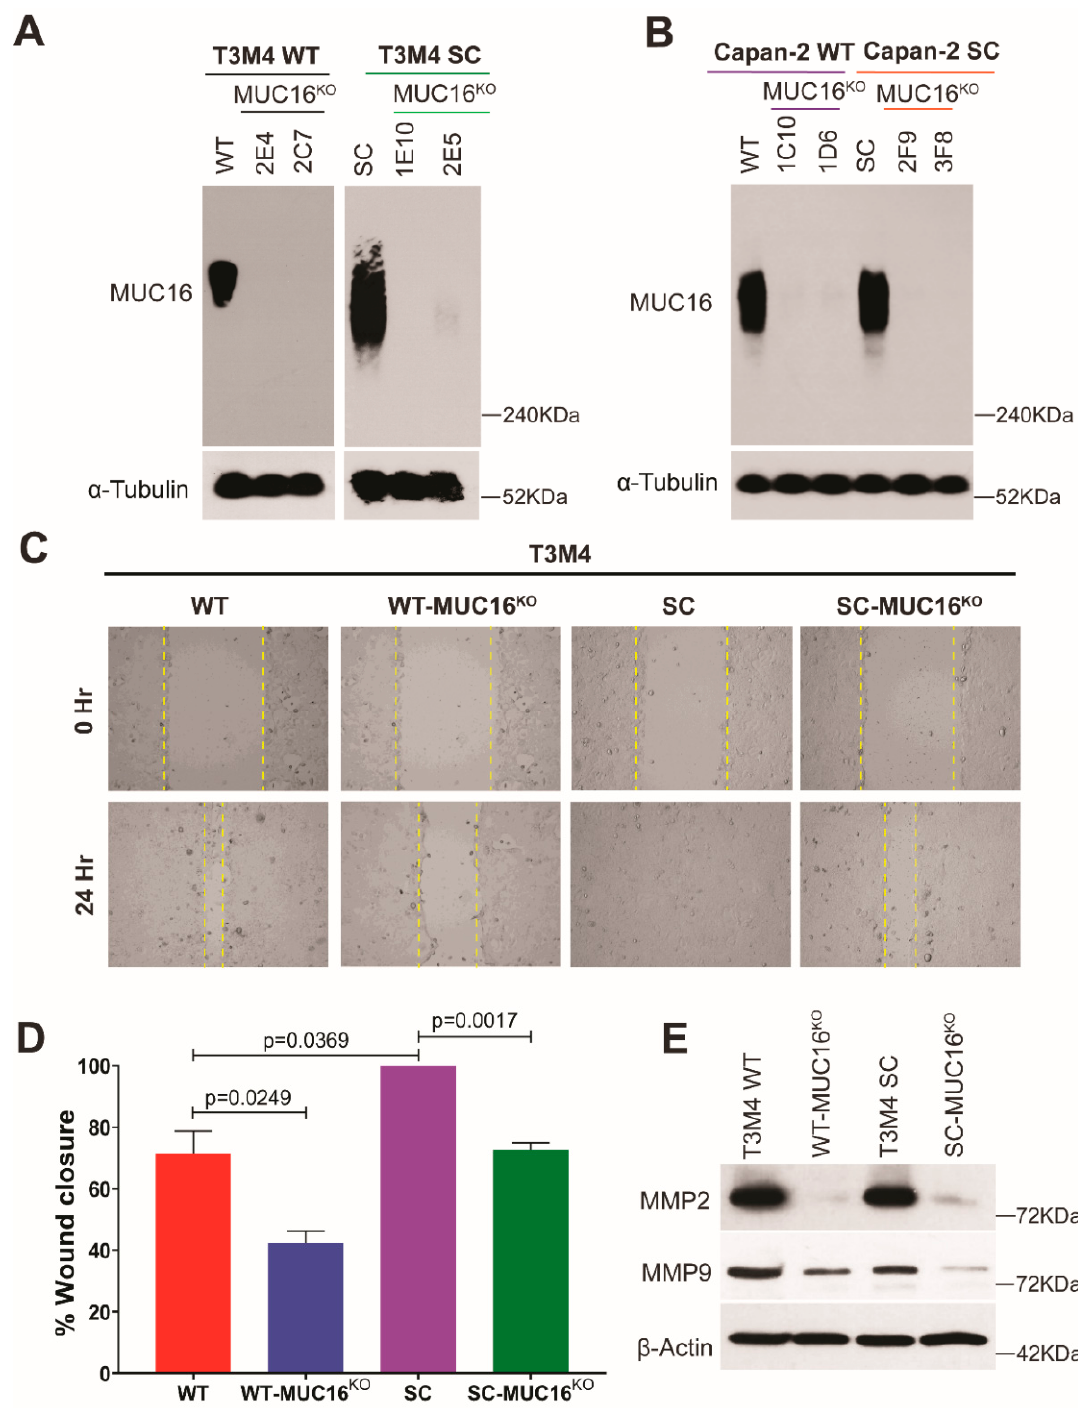
Figure 1. MUC16 knockout causes a decrease in PDAC cell migration. Western blot confirmation of CRISPR-Cas9-mediated genetic deletion of MUC16 in ( A ) T3M4 WT and SC cells; and ( B ) Capan-2 WT and SC cells; loading control: α -tubulin; ( C ) wound healing assay with T3M4 WT, WT-MUC16 KO , SC, SC-MUC16 KO cells; images captured at 0 h and 24 h; ( D ) quantification of the percentage of wound closure, as described previously [14]; p < 0.05 is considered statistically significant; ( E ) Western blot analysis of MMP2 and MMP9 in T3M4 WT, WT-MUC16 KO , SC, SC-MUC16 KO cells; loading control: β -actin.